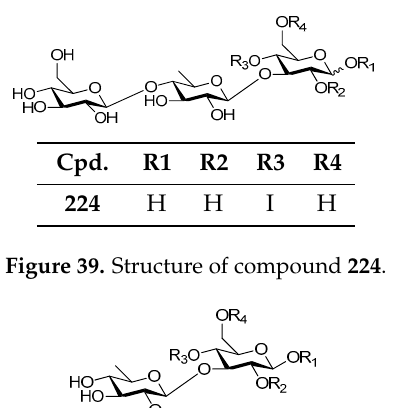
Figure 38. Structures of compounds 221 – 223 .